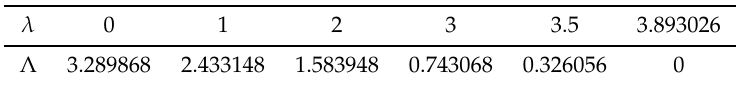
Table 1. Critical values of the load